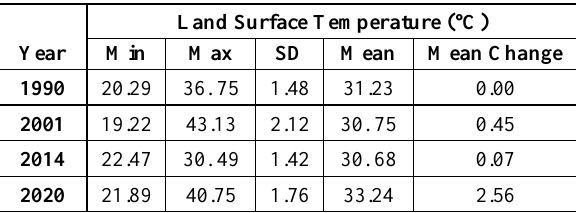
Table 5: Descriptive analysis of land surface temperature The mean thermal signature for each land cover type is shown in (Figure 5). Vegetation and water bodies exhibited the lowest mean LST, which can be attributed to their higher latent heat transfer and evapotranspiration (Ahmed et al., 2002). Highest mean LST was observed in agricultural land, bare-land and built- up areas. Bare-land reflects incoming radiation thereby warming up faster than other land cover types (Huang et al., 2015). These findings justify the dependence of LST on land cover types. Figure 5: Thermal signature of land cover types